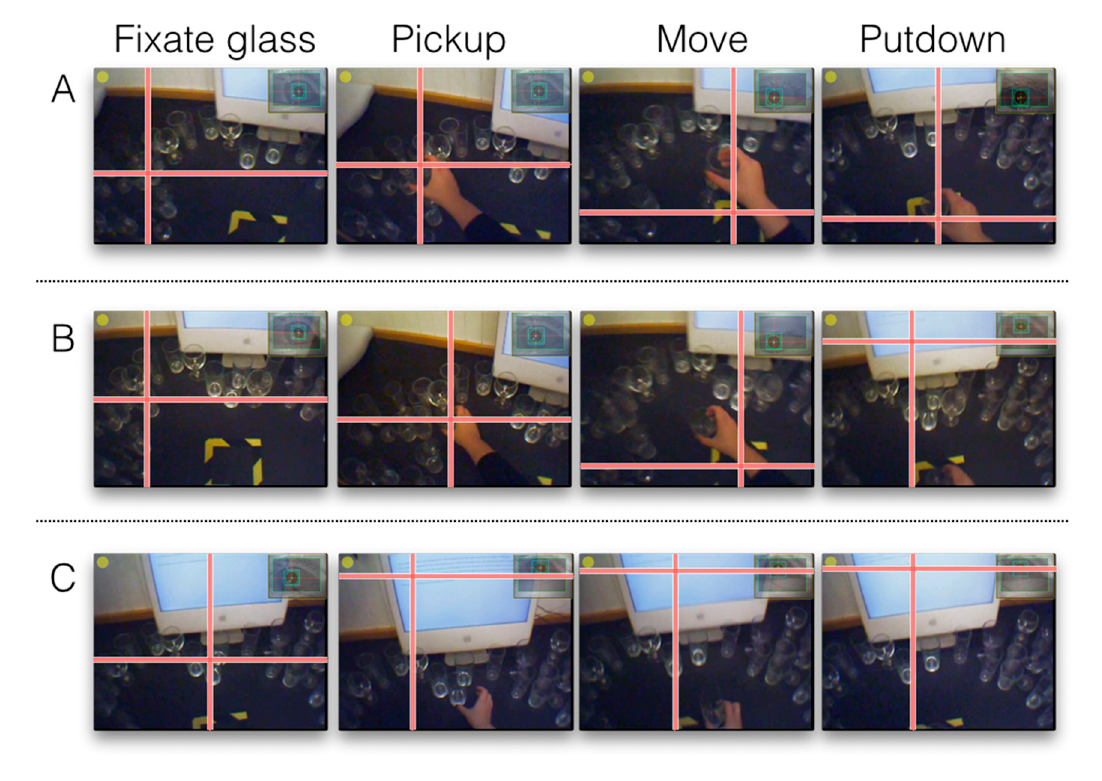
Figure 2. Examples of the types of object putdowns we recorded. ( A ) shows a fully-guided putdown, where the participant fixates on the glass until they pick it up, and then saccades to the setting-down location where they fixate for the entire duration of the execution of the movement and putdown of the glass. ( B ) shows a partially-guided putdown, where the visuomotor strategy is the same as ( A ), except that they saccade away from the set-down location before the put-down is complete. ( C ) shows an entirely unguided putdown where the participant fixates on the glass, then saccades back to the screen while they pick-up, and move and put-down the glass while fixating on the screen.